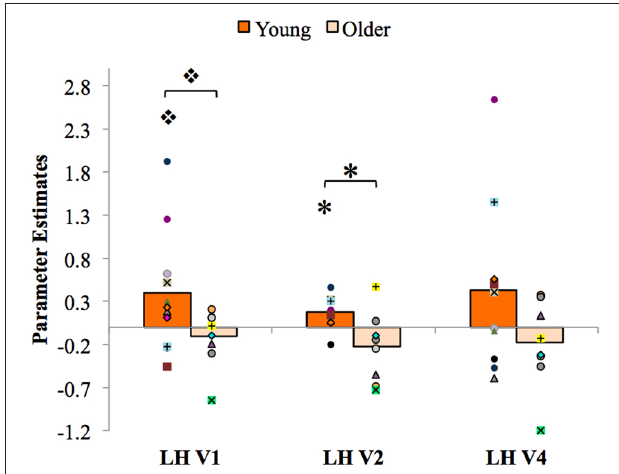
FIGURE 6 | Psychophysiological interaction (PPI) analysis results, with individual participants’ data superimposed. LH, left hemisphere. ∗ p < 0.05,